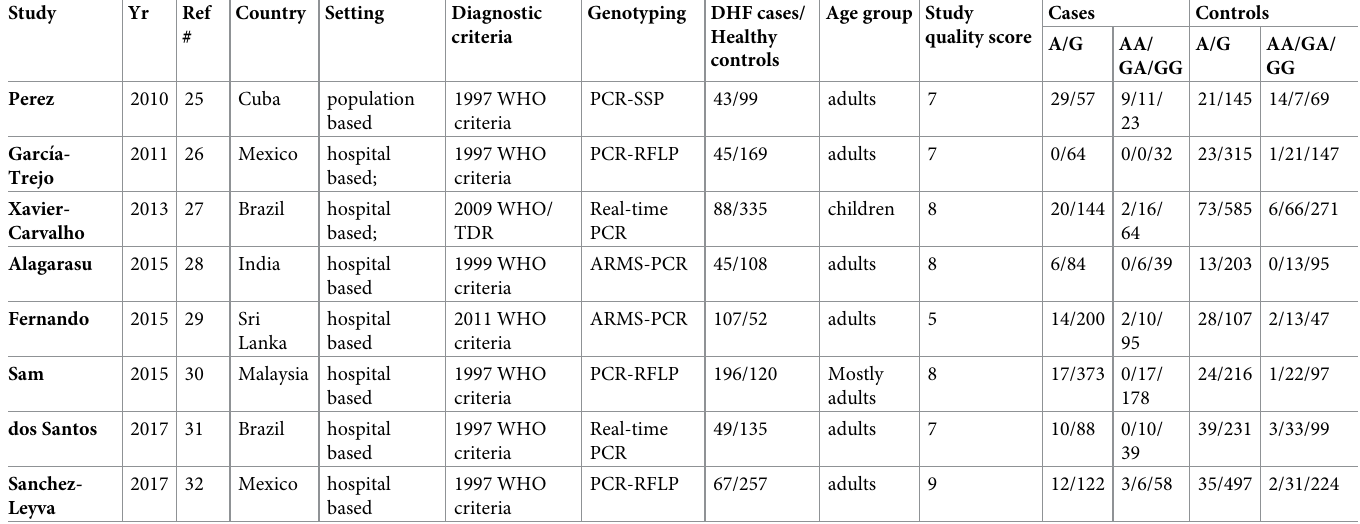
Table 1. Characteristics of the studies included in the meta-analysis.